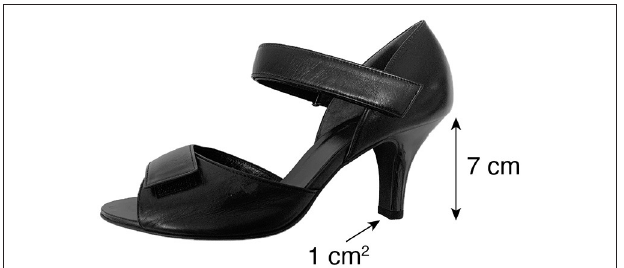
FIGURE 1 | A side view of the custom-made high-heeled shoe (heel area 1 cm 2 , heel height 7cm). The shoe had two adjustable straps with Velcro fasteners around the ankle and the dorsum of the